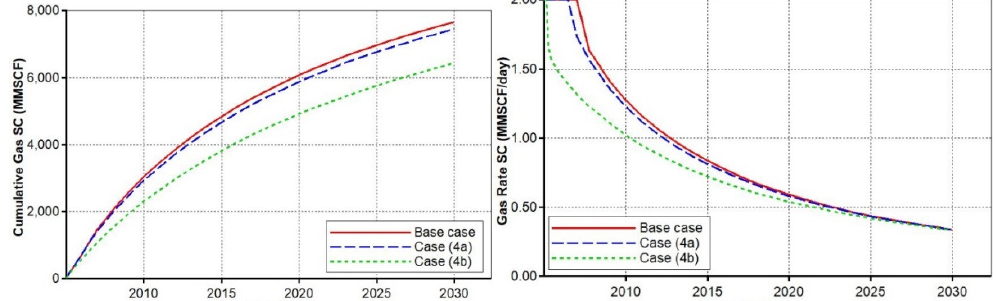
FIG. 8. EFFECT OF RESERVOIR HETEROGENEITY ON GAS PRODUCTION RATE AND CUMULATIVE GAS PRODUCTION